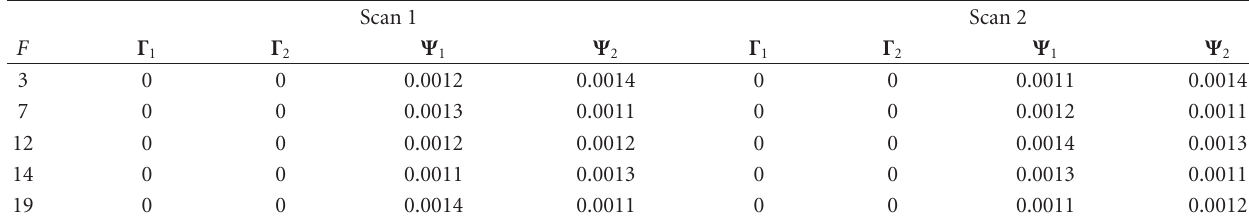
Table 3: Identity errors [mm] for Γ 1 , Γ 2 , Ψ 1 , and Ψ 2 are given for random frames ( F ) of the two cardiac cine MRI